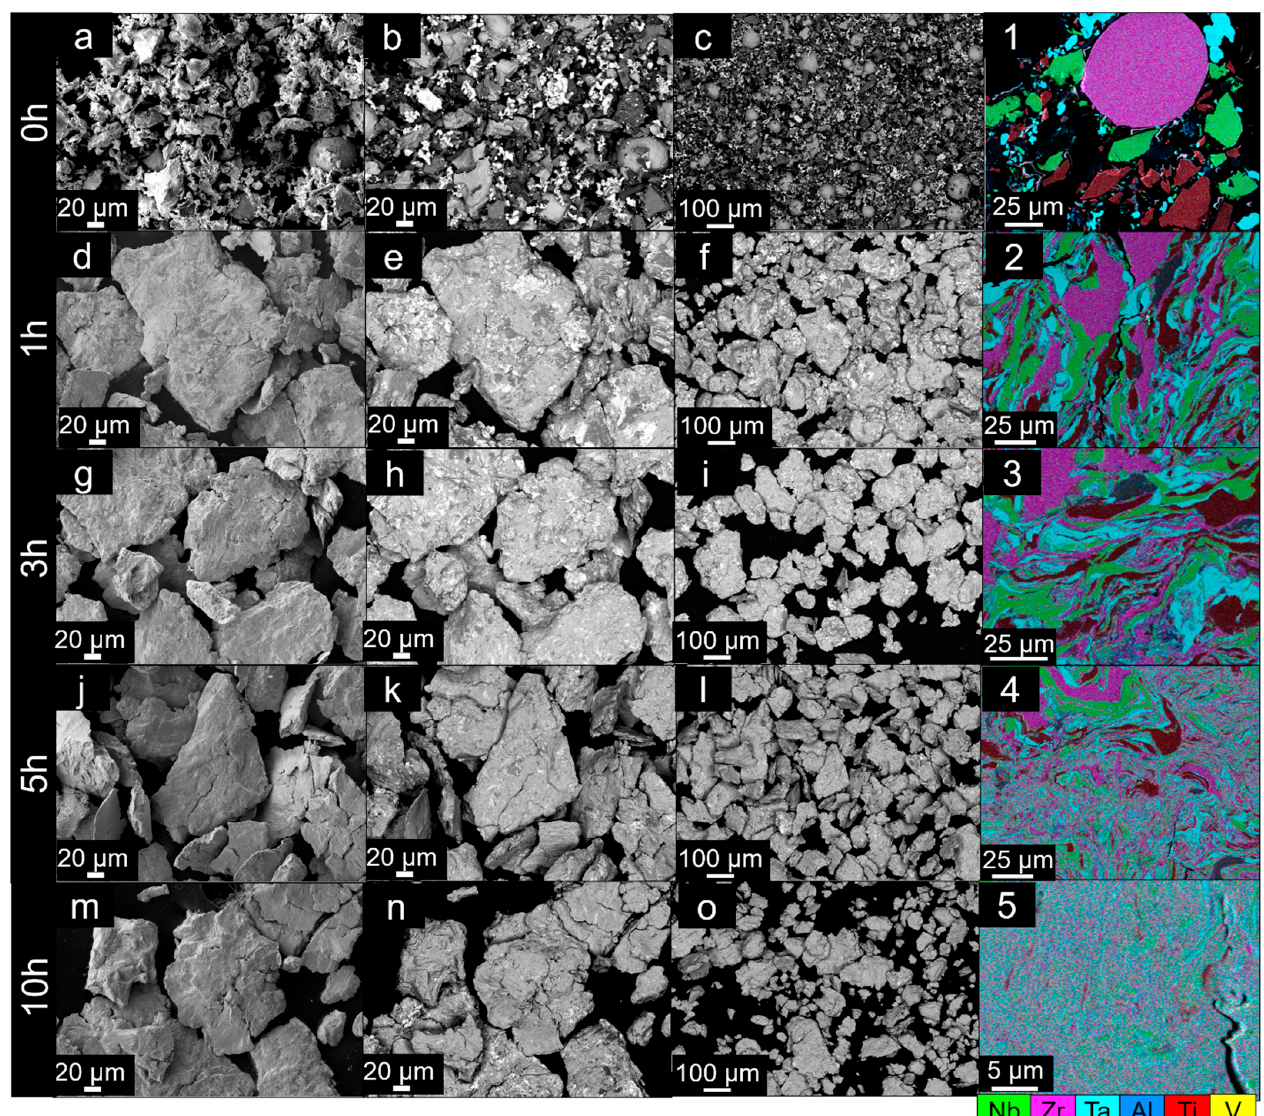
Figure 3. SEM images of Al 0.3 NbTa 0.8 Ti 1.5 V 0.2 Zr powders after different milling times from 0 to 10 h, respectively. The milling times are noted on the left side of each row of images. ( a , d , g , j , m ) SEM micrographs using SE detector showing powders in detail after each milling from 0 to 10 h, in order. ( b , e , h , k , n ) Corresponding SEM images using a BSE detector showing powders in detail after each milling. ( c , f , i , l , o ) SEM images using BSE mode to exhibit an overview of the powders in lower magnifications. ( 1 – 5 ) EDS maps with all elements in color are shown, taken from the particle cross-section of each powder milled from 0 to 10 h, respectively.